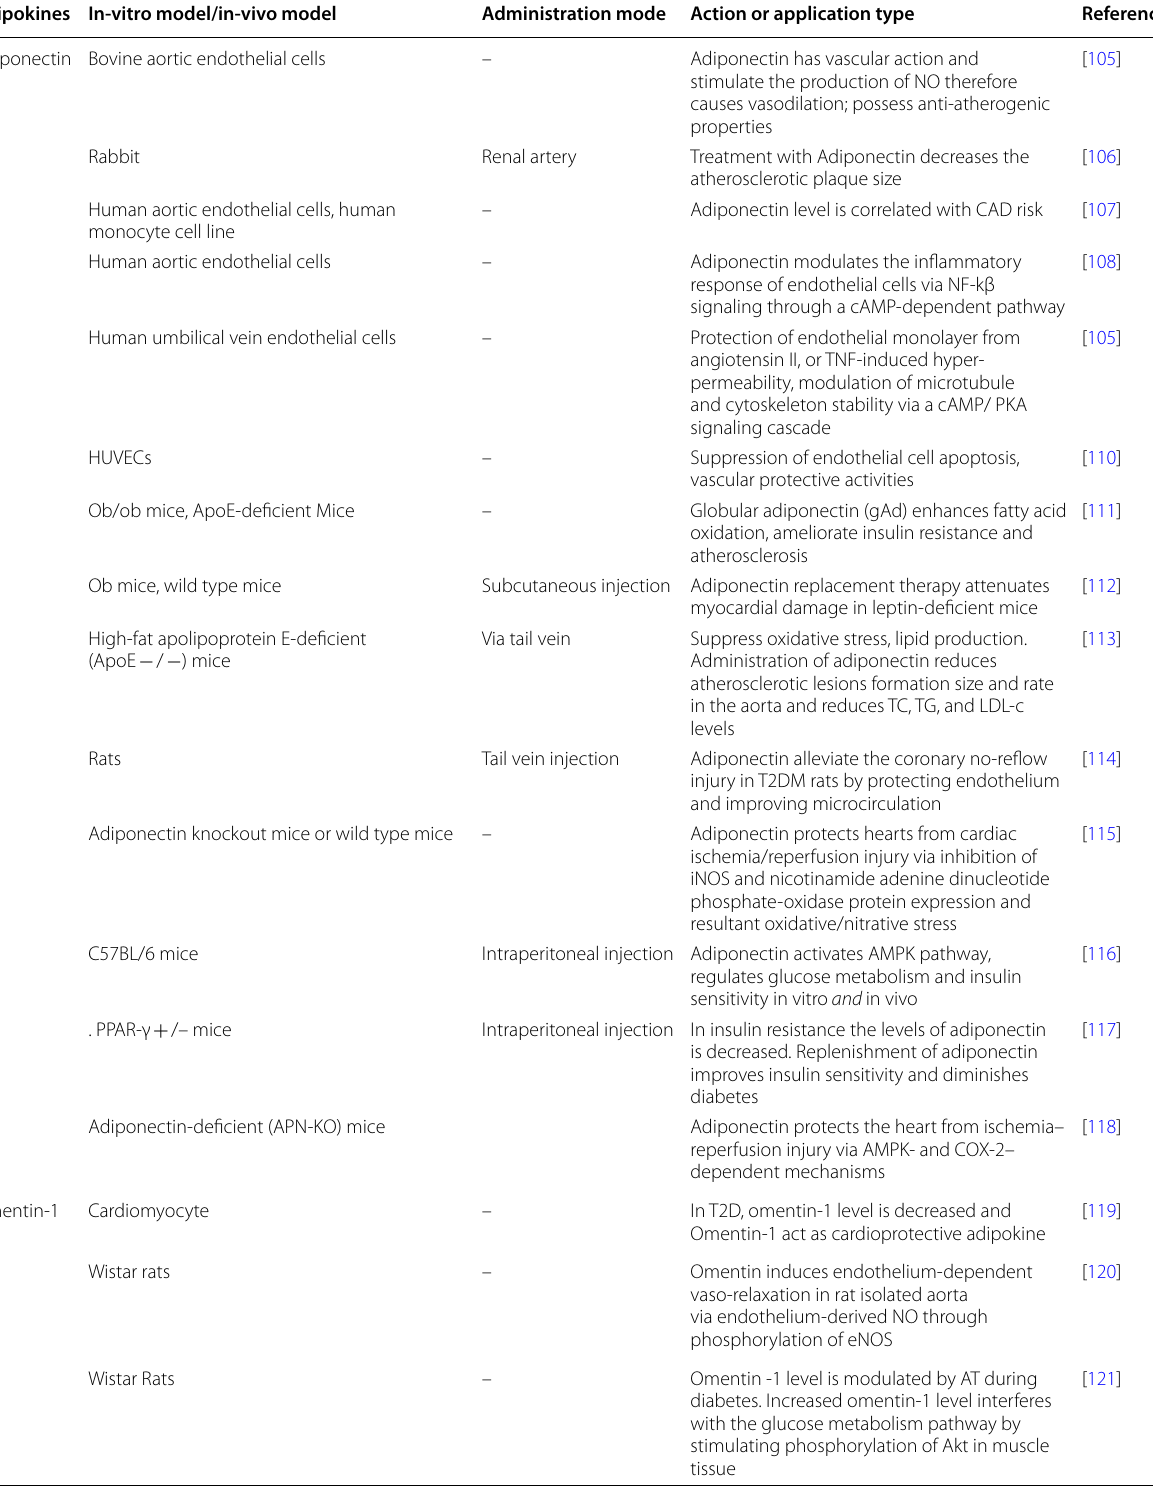
Table 1 Preclinical evidence of anti-inflammatory adipokines in insulin resistance and atherogenic dyslipidemia Adipokines In‑vitro model/in‑vivo